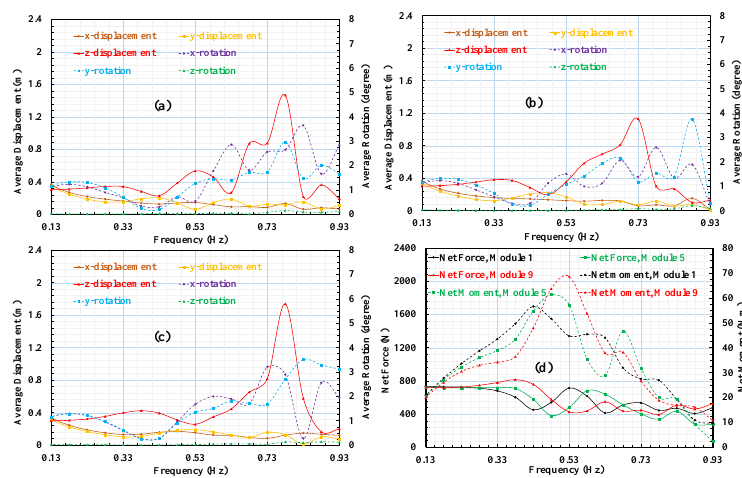
Figure 8. Average displacement of ( a ) module 1, ( b ) module 5, ( c ) module 9, and ( d ) net forces and moments corresponding to 0° of the wave direction .